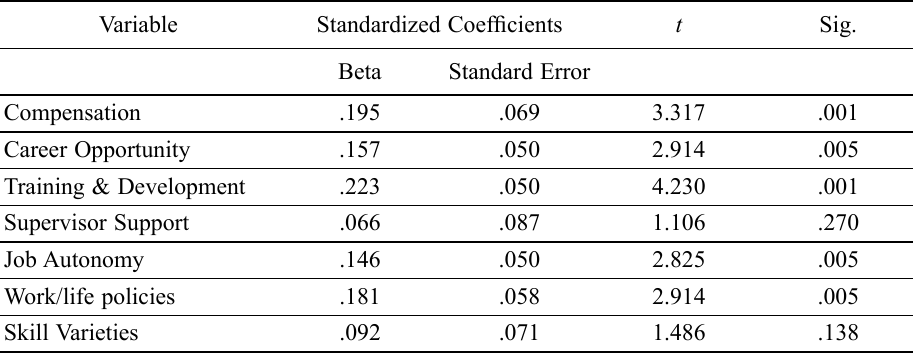
Table 4. Influence of independent variables on affective